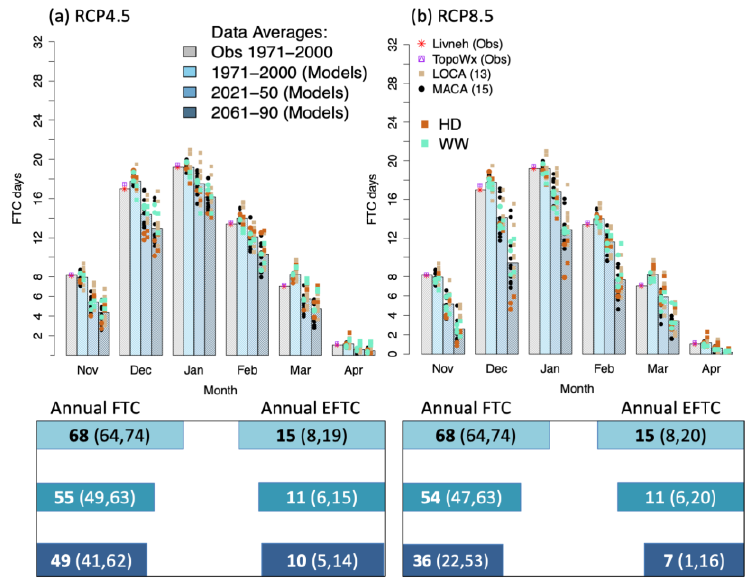
Figure 2. Bar plot (top) displays the historical observed (asterisk for Livneh, box and triangle for TopoWx, and gray bar for model ensemble average; 1971–2000) and projected monthly (November– April) total freeze–thaw cycles for ( a ) RCP4.5 and ( b ) RCP8.5. Mean values from each MACA (dots) and LOCA (squares) projection are shown, with different shading for HD and WW models. Bottom schematics represent the annual multi-model means for ( a , b ) above, with FTC ( left ) and EFTC ( right ) for the three reference periods and their respective scenarios with the total sample spread (low, high) in